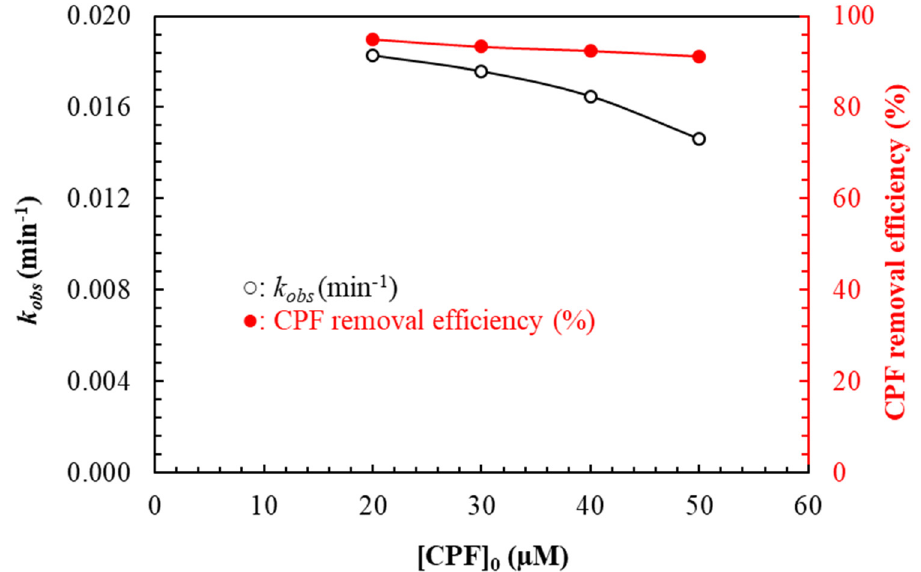
Figure 11. The effect of CPF concentration on k obs (min − 1 ) and CPF removal efficiency (%) observed in the solar light-assisted oxidative degradation of CPF catalyzed by Fe III -CS-GLA in aqueous solution. Experimental conditions: [CPF] 0 : 20–50 µ M; [Fe III ] 0 in Fe III -CS-GLA: 1.25 mM; [GLA] 0 in Fe III -CS-GLA: 90 mM; [H 2 O 2 ] 0 : 6 mM; volume of CPF solution: 250 mL; pH: 3; light intensity: 70,000–90,000 Lux; solar light irradiation time: 180 min.